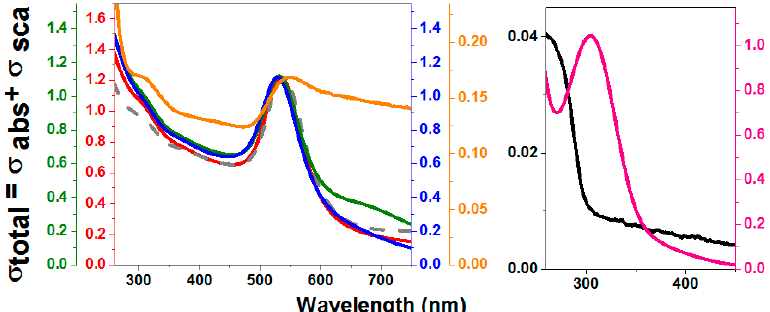
Figure 4. UV-vis spectra of rNEL-GNP synthesized with different NEL concentrations. Spectra of NEL-GNPs were obtained from the synthesis using NEL at 200, 40, 8 and 2 nM, corresponding to 1000, 200, 40 and 10 nM of exposed sulfhydryls. Red: NEL-GNP (2 nM). Green: NEL-GNP (8 nM). Blue: NEL-GNP (40 nM). Orange: NEL-GNP (200 nM). Gray dashed line: GNP-HEPES without Protein. Black: NEL protein. Pink: reaction without HEPES. The wavelength of 300 nm corresponds mainly to Au-protein complex absorption and 535 nm to the plasmonic band of the nanoparticle. Spectra were obtained in a spectrophotometer Evolution 200 (Thermo Scientific) at room temperature.